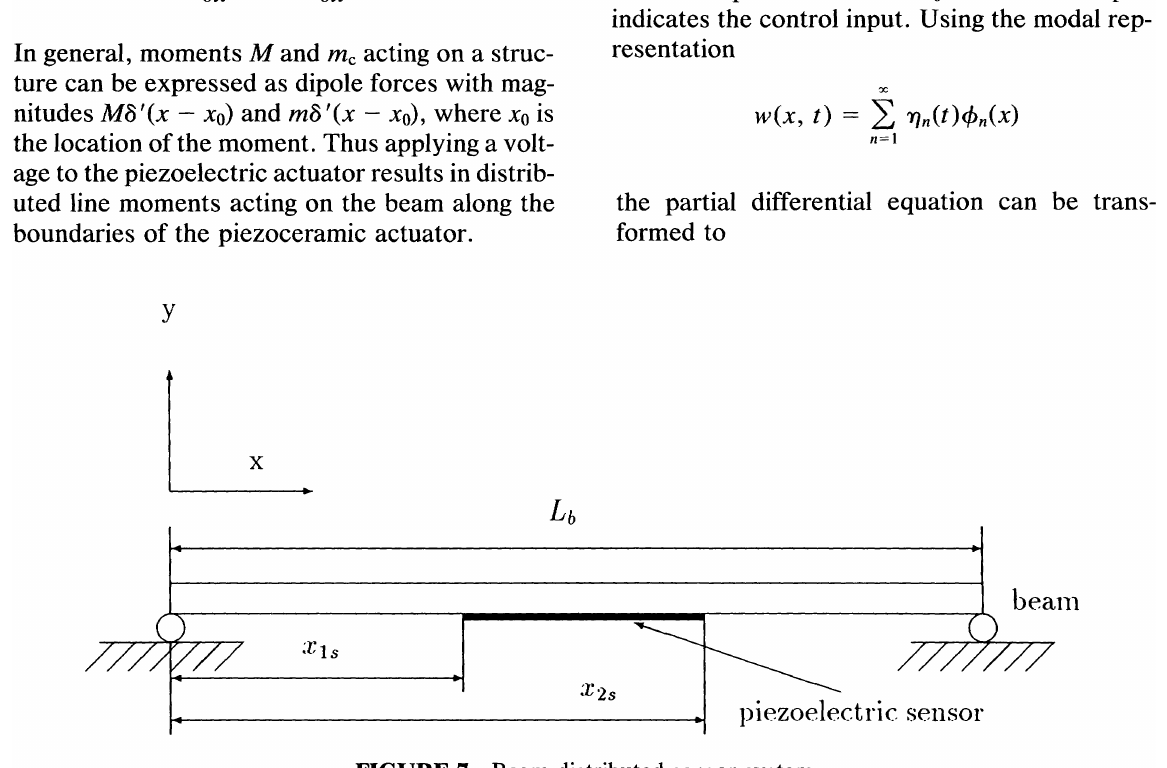
FIGURE 7 Beam-distributed sensor